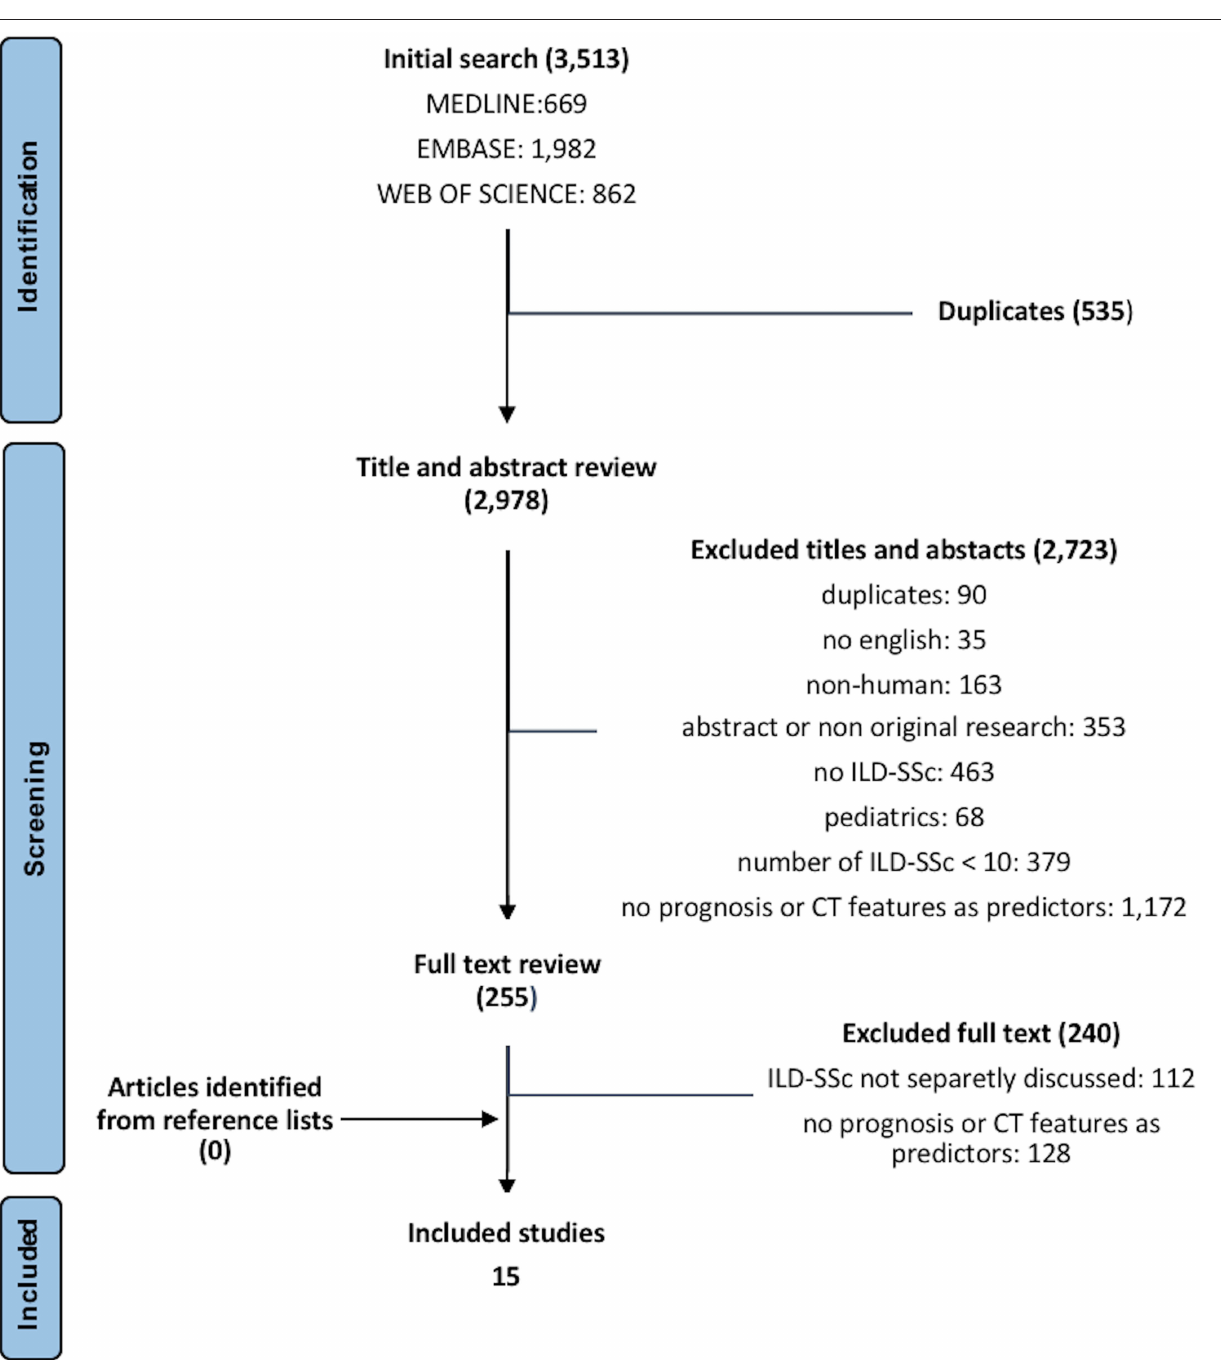
mean age ranged from 48 to 67 years, 440/2,069 (21.3%) were men, and 1,546/2,309 (66.9%) were not-smokers. The mean disease duration ranged from 1.1 to 12.2 years in nine studies (9–11, 16–20, 22), the median ranged from 1.0 to 5.0 years in three (12, 14, 15). Anti-centromere antibodies were positive in